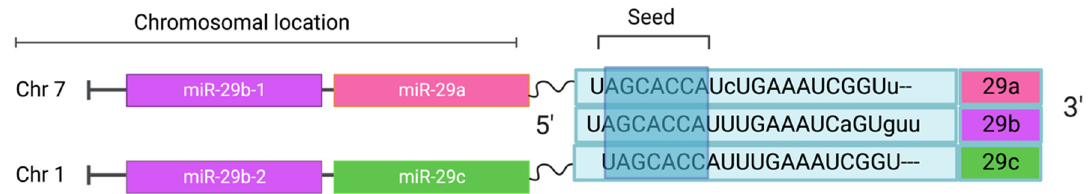
Figure 2. Schematic representation of the miR-29 family members: miR-29a, -29b, and -29c. The family is transcribed from two chromosomal positions forming a bi-cistronic transcriptional unit; both miR-29a and miR-29b1 are found on chr7, while miR-29b2 and miR-29c are located on chr1. miR-29 family members have identical seed sequences (darker blue box) along with similar mature miRNA sequences.